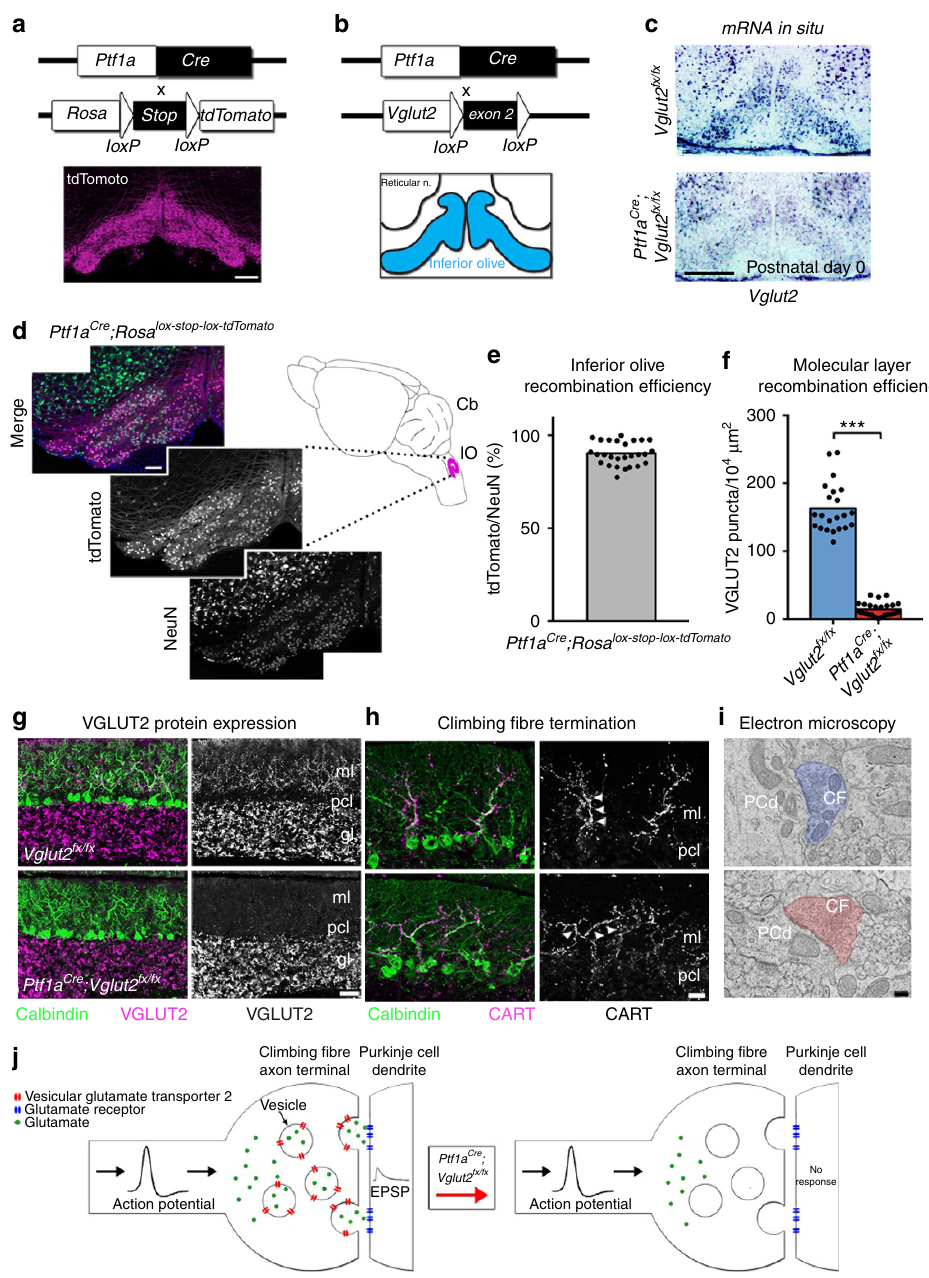
Figure 1 | An in vivo conditional genetic strategy for silencing neurotransmission at excitatory olivocerebellar axon terminals in mice. ( a ) Ptf1a Cre can be used to target the inferior olivary nucleus as demonstrated by tdTomato expression. Scale bar, 200 m m. ( b ) Using the same Ptf1a Cre driver, exon 2 of Vglut2 can be selectively removed and Vglut2 deleted from the inferior olive. ( c ) An antisense in situ probe for Vglut2 mRNA reveals its removal from the inferior olive by postnatal day 0. Scale bar, 200 m m. ( d ) Ptf1a Cre -driven tdTomato expression compared with the distribution of NeuN-positive cells in the inferior olive, as schematized in the right panel. Scale bar, 100 m m. Schematic reproduced in part, with permission, from Reeber et al. 78 . ( e ) Quantification of the recombination efficiency of Ptf1a Cre by dividing the number of tdTomato-positive cells by the number of NeuN-positive cells in the inferior olive in Ptf1a Cre ;Rosa lox-stop-lox-tdTomato mice; n ¼ 3 mice. ( f ) Quantification of VGLUT2 protein expression in the molecular layer of lobules in all four transverse zones of the cerebellum show a significant reduction in Ptf1a Cre ;Vglut2 fx/fx mice ( P ¼ 9.294 (cid:2) 10 (cid:3) 16 ; Student’s unpaired t -test); n ¼ 4 mice of each genotype. *** P o 0.001. ( g ) Examples of expression of VGLUT2 protein in the molecular layer of lobule VI in a Vglut2 fx/fx and a Ptf1a Cre ;Vglut2 fx/fx mouse. Scale bar, 50 m m. ( h ) CART expression in climbing fibres in the molecular layer of lobule IX in a Vglut2 fx/fx and a Ptf1a Cre ;Vglut2 fx/fx mouse. Note that although CARTexpression in lobules IX and X is predominant and heaviest in climbing fibres, in other lobules it does label a subset of mossy fibres and scattered beaded fibres 19 . Arrowheads point to climbing fibres. Scale bar, 20 m m. ( i ) Electron microscopy showing the ultrastructure of climbing fibre synapses onto large, Purkinje cell dendritic branches in a Vglut2 fx/fx and a Ptf1a Cre ;Vglut2 fx/fx mouse. Scale bar, 200 nm; n ¼ 4 mice of each genotype. ( j ) Schematic depicting the outcome of genetically silencing climbing fibre terminals. CF, climbing fibre; gl, granular layer; pcl, Purkinje cell layer; ml, molecular layer; PCd, Purkinje cell dendrite; CART, cocaine- and amphetamine-related transcript.